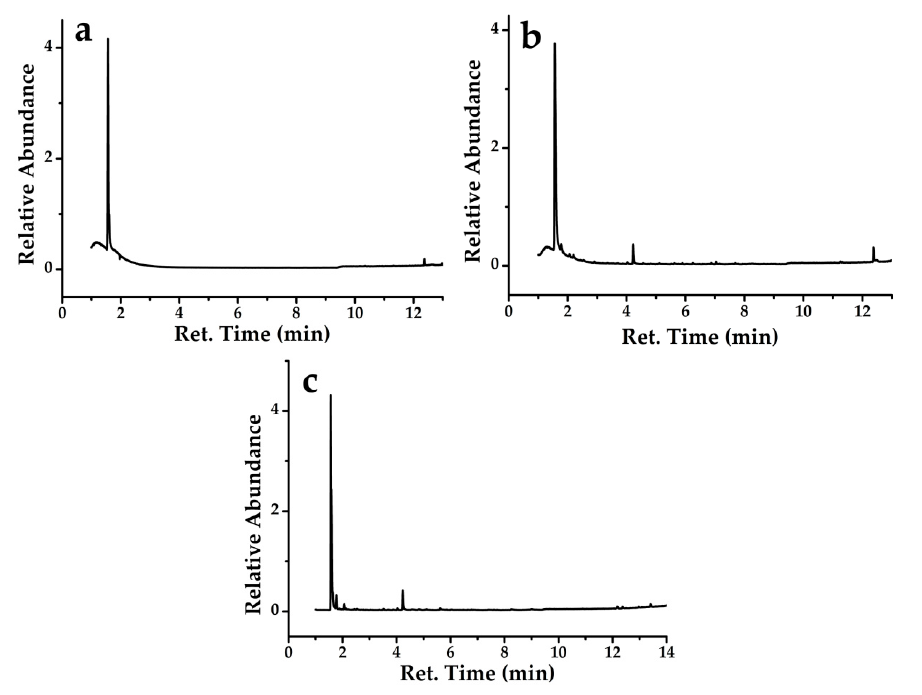
Figure 5. ( a ) HRR, ( b ) THR and ( c ) TSR curves of ZnAlg and ZnAlg/Cu 2 O changing with time.